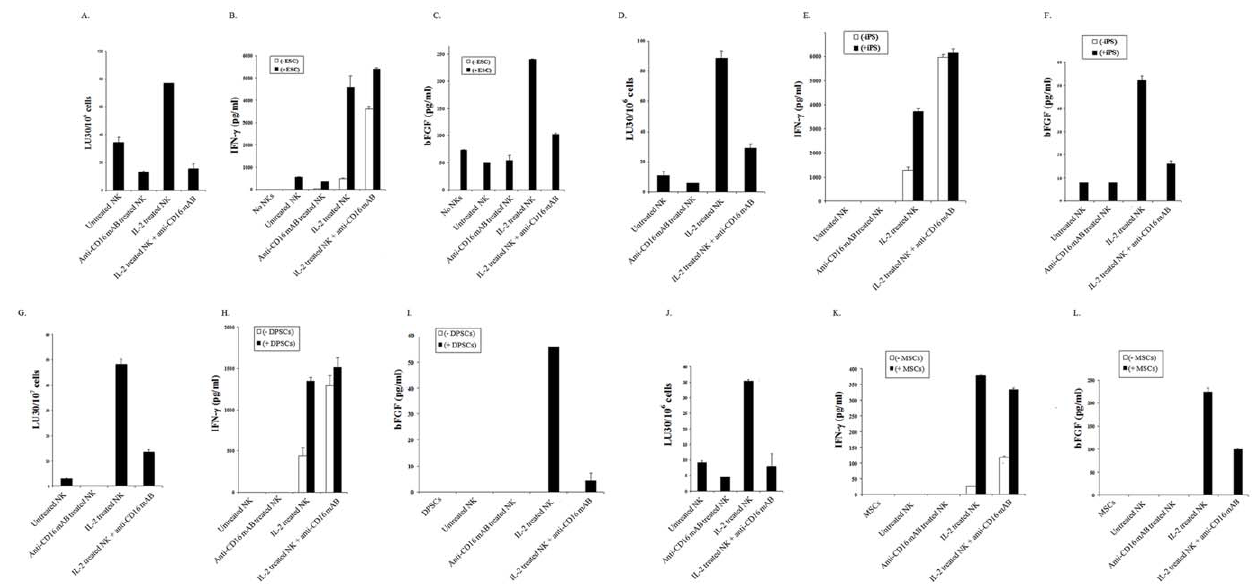
Figure 3. Lysis of hESCs, hiPSCs, hDPSCs and hMSCs by untreated and IL-2 treated NK cells is inhibited by anti-CD16 antibody treatment, however, the same treatment induced significant secretion of IFN- c by the NK cells. NK cells (1 6 10 6 /ml) were left untreated or treated with IL-2 (1000 units/ml), or anti-CD16 mAb (3 m g/ml) or a combination of IL-2 (1000 units/ml) and anti-CD16 mAb (3 m g/ml) for 12-24 hours before they were added to 51 Cr labeled hESCs, hiPSCs, hDPSCs and hMSCs. NK cell cytotoxicities were determined using a standard 4 hour 51 Cr release assay, and the lytic units 30/10 6 cells were determined using inverse number of NK cells required to lyse 30% of hESCs ( A ), hiPSCs ( D ), hDPSCs ( G ) and hMSCs ( J ) 6 100. NK cells were treated as described above and each NK sample at (1 6 10 5 /ml) were either cultured in the absence or presence of hESCs, hiPSCs, hDPSCs and hMSCs at an NK to stem cell ratio of 1:1. After an overnight culture, supernatants were removed from the co-cultures and the levels of IFN- c ( B , E , H , K ), and bFGF ( C , F , I , L ) secretion were determined using specific ELISAs. One of a minimum three representative experiments for each stem cell population is shown in this figure.